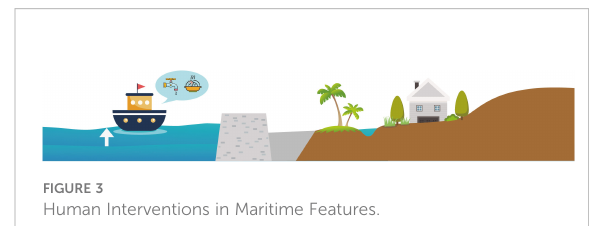
FIGURE 3 Human Interventions in Maritime